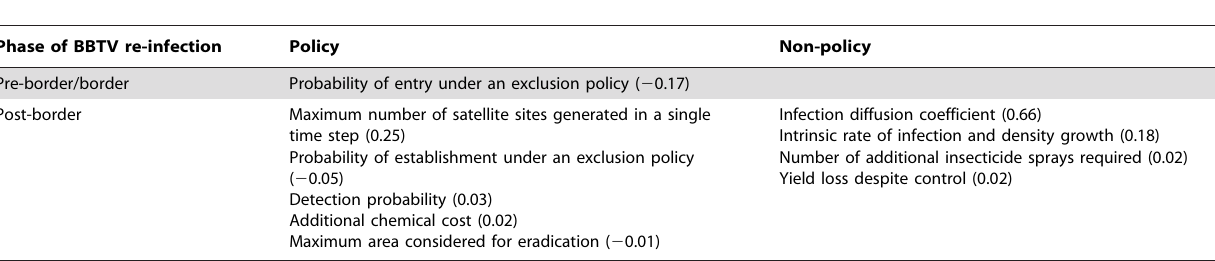
Table 3. Policy and non-policy input parameters.